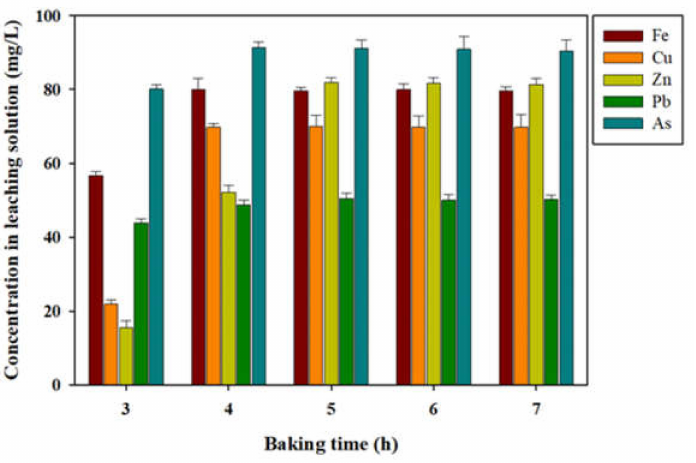
Figure 11. Leaching valuable metals and As on the hot water leaching as a function of time. Condition, H 2 SO 4 ; concentration, 1.0 mL; and baking temperature, 400 ◦